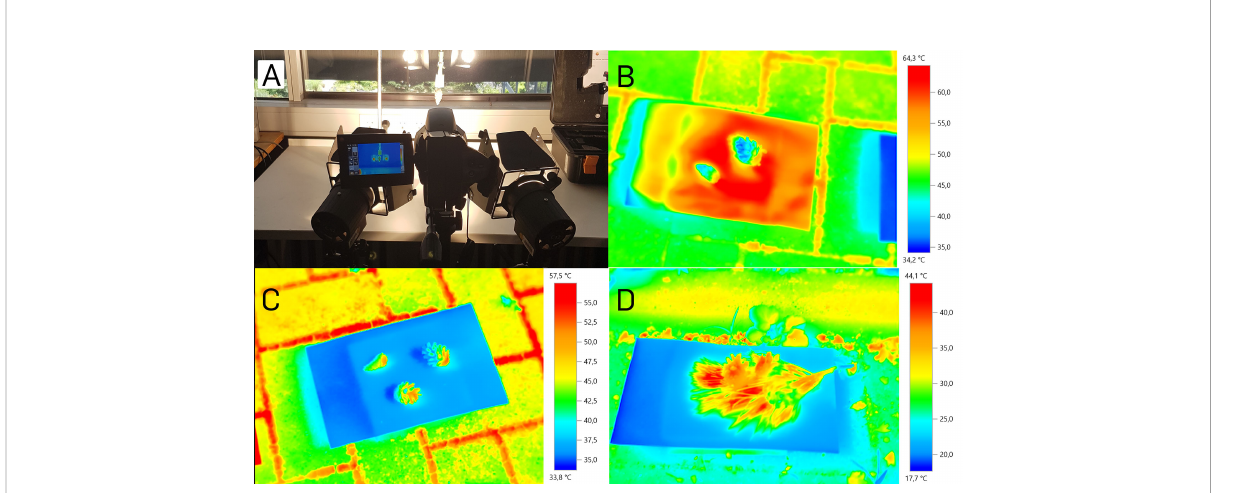
FIGURE 3 Cone surface temperatures during opening. (A) Indoor measurement setup with two arti fi cial light sources. (B) Cones in the outdoor experiment on black cardboard. (C) Cones in the outdoor experiment on white cardboard. (D) Cones in the outdoor experiment on white cardboard surrounded by a pine